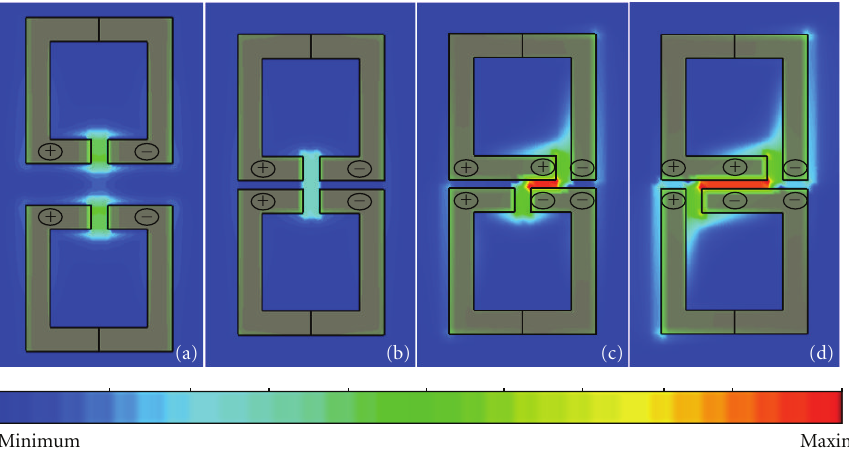
Figure 3: The numerically simulated electric field strength distributions for the coupled SRRs: (a) MM1 (b), MM2 (c), MM3 (d), and MM4. The electric field strength is indicated by the color map at the bottom. The polarity of the induced electronic charges on the SRR arms is indicated in the